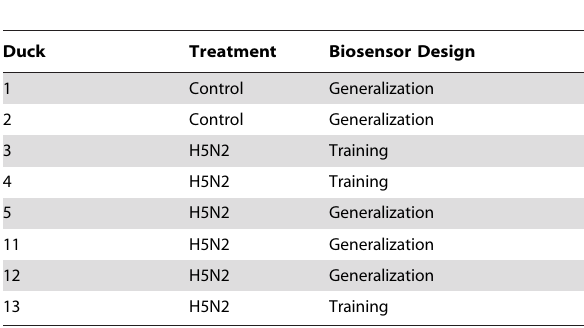
Table 1. Donor IDs, treatments, and use of feces in behavioral